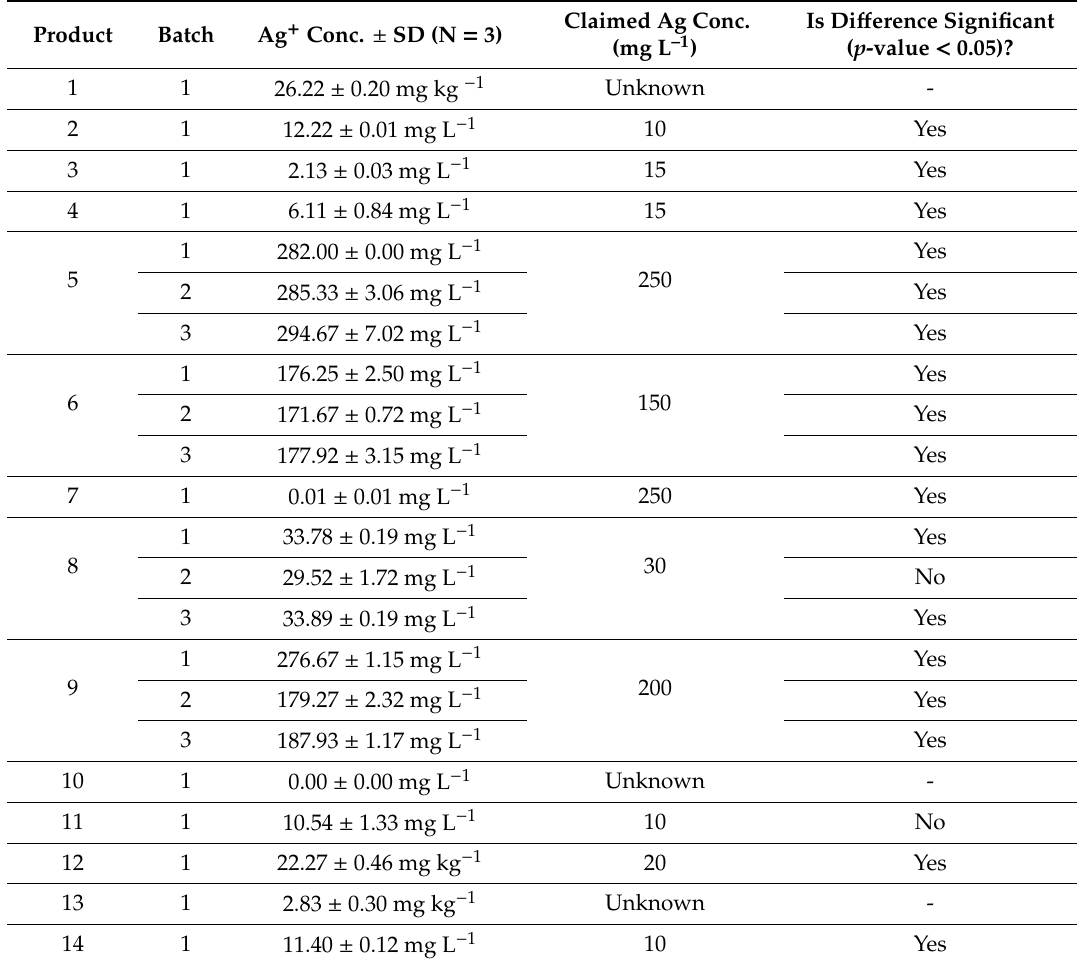
Table 4. ICP-OES results of the 14 di ff erent silver products and the three di ff erent production batches of products 5, 6, 8, and 9. One-sample T-tests were used to test if the measured concentration was significantly di ff erent from the claimed concentration on the